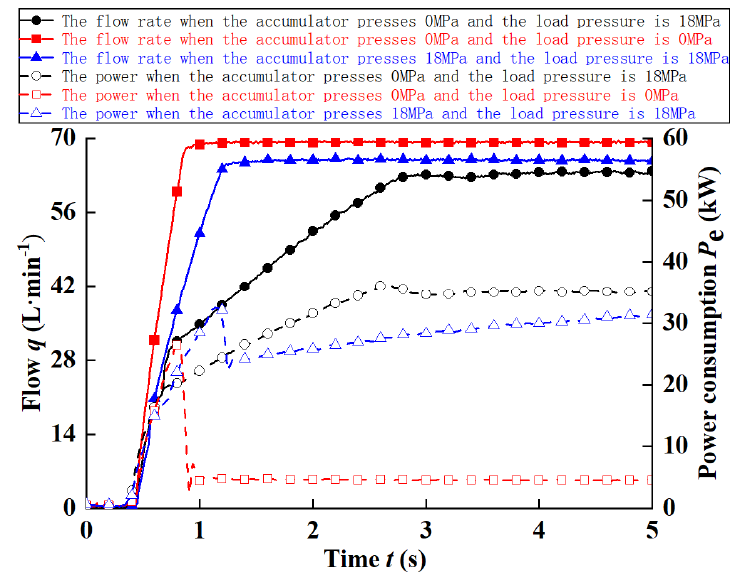
Figure 15. Dynamic response of pump output flows.